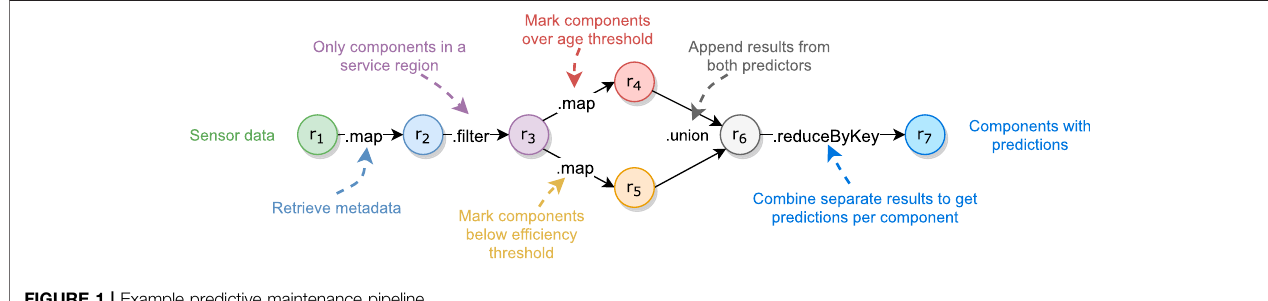
FIGURE 1 | Example predictive maintenance